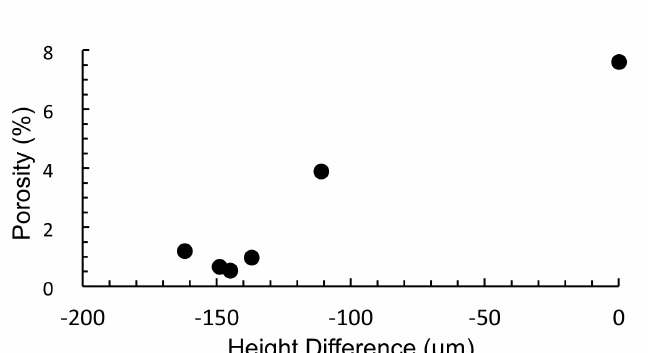
Figure 15. Porosity measured by X-CT of structures created by PBF-LB/M as a function of the height difference measured in-process by Fringe Projection. The values represent measurements using samples presented in Figure 14 after further growth to layer 20. The values of the height difference are taken from layer 20, the center of the cubes, which consist of 40 layers at the end of the growth process. For an easier overview, the material with the highest degree of porosity was used as a height reference with height difference = 0. Measured values follow the tendency that the height difference increases with the degree of sample porosity. The value of the structure located individually in the upper part of Figure 14a was not taken into account because the z-values do not appear plausible due to the large distance between the melted tracks (compare Figure 14b). Sample parameters are given in Table A1 of Appendix